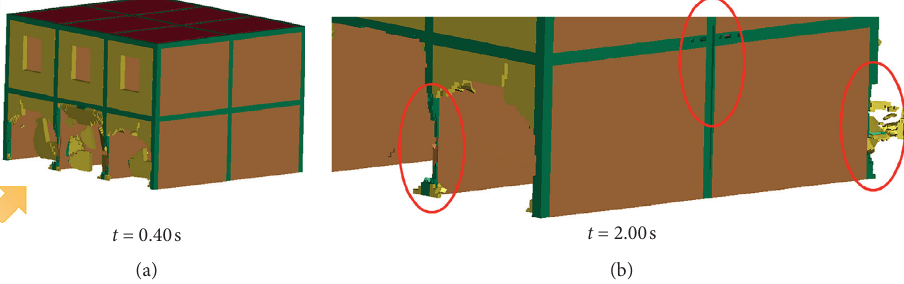
Figure 7: Snapshots in the scenario of s � 0, h � 1.6m, and v � 8.0m/s: (a) oblique view, and (b) local enlarged view (red circles representing the zone where damage had occurred).